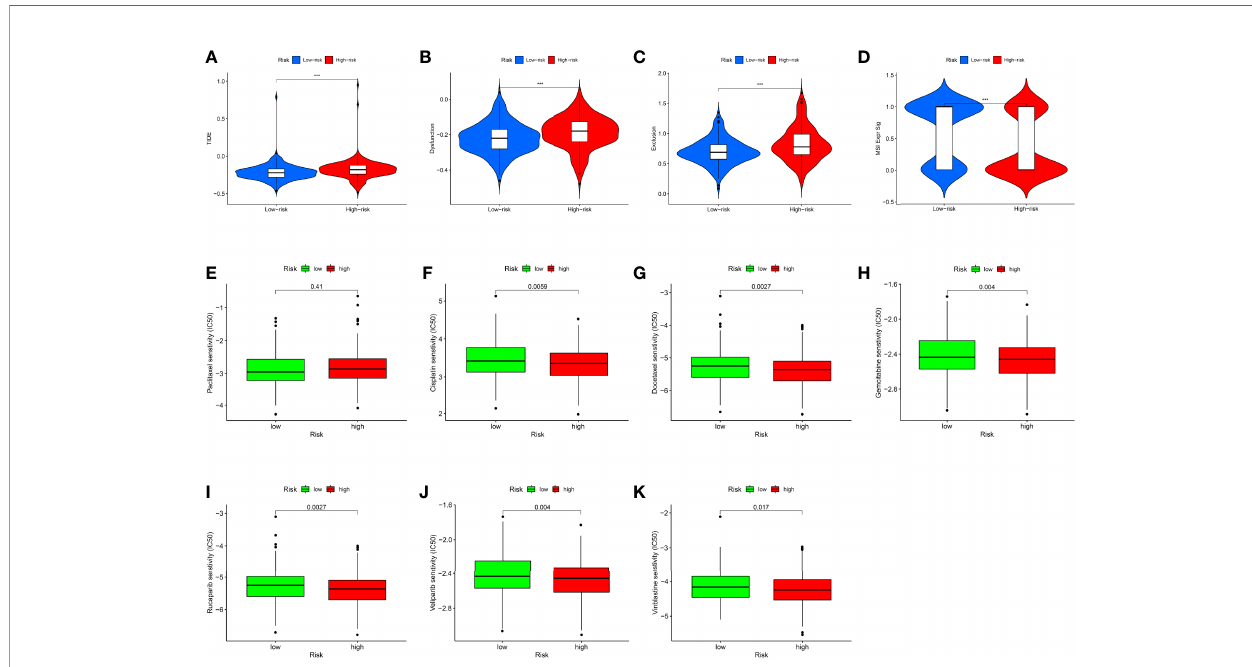
FIGURE 7 | The role of RMW score in ovarian cancer (OC) treatment drug sensitivity. (A – C) The correlation between the RMW score and Tumor Immune Dysfunction and Exclusion (TIDE) Score. (D) Relationships between RMW score and microsatellite instability (MSI). (E – K) Relationships between RMW score and chemotherapeutic sensitivity. Adjusted p-values were shown as ***p <